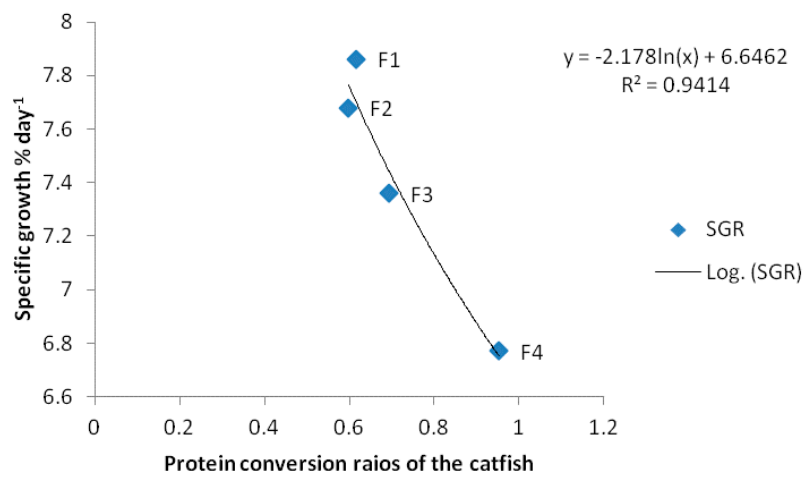
Figure 1. Relationship between the specific growth rate (SGR)of African catfish C. gariepinus fed with algae C. vulgaris diets as substitute of fishmeal for 60 d.